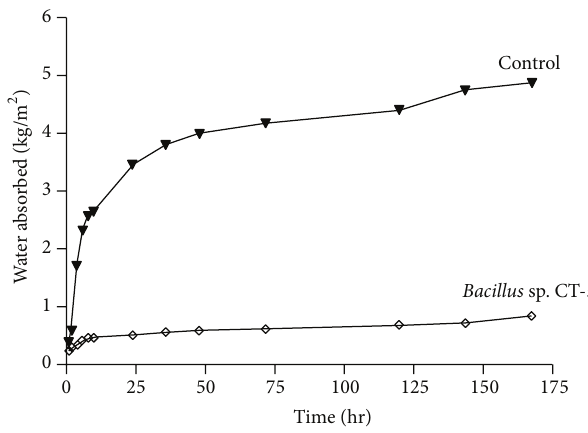
Figure 1: Water absorption experiment on Bacillus sp. CT-5